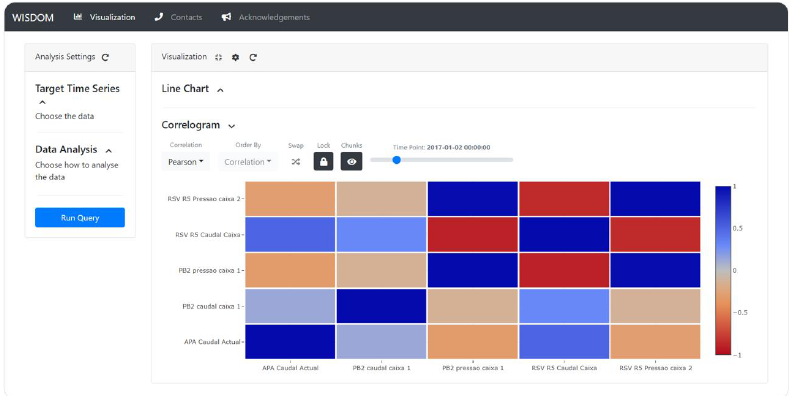
Figure 4. Decision support tool: correlogram section with coefficient and spatial sorting and zoom- ing